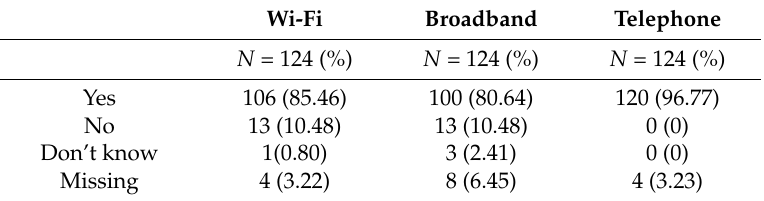
Table 3. The technology respondents stated that they have access